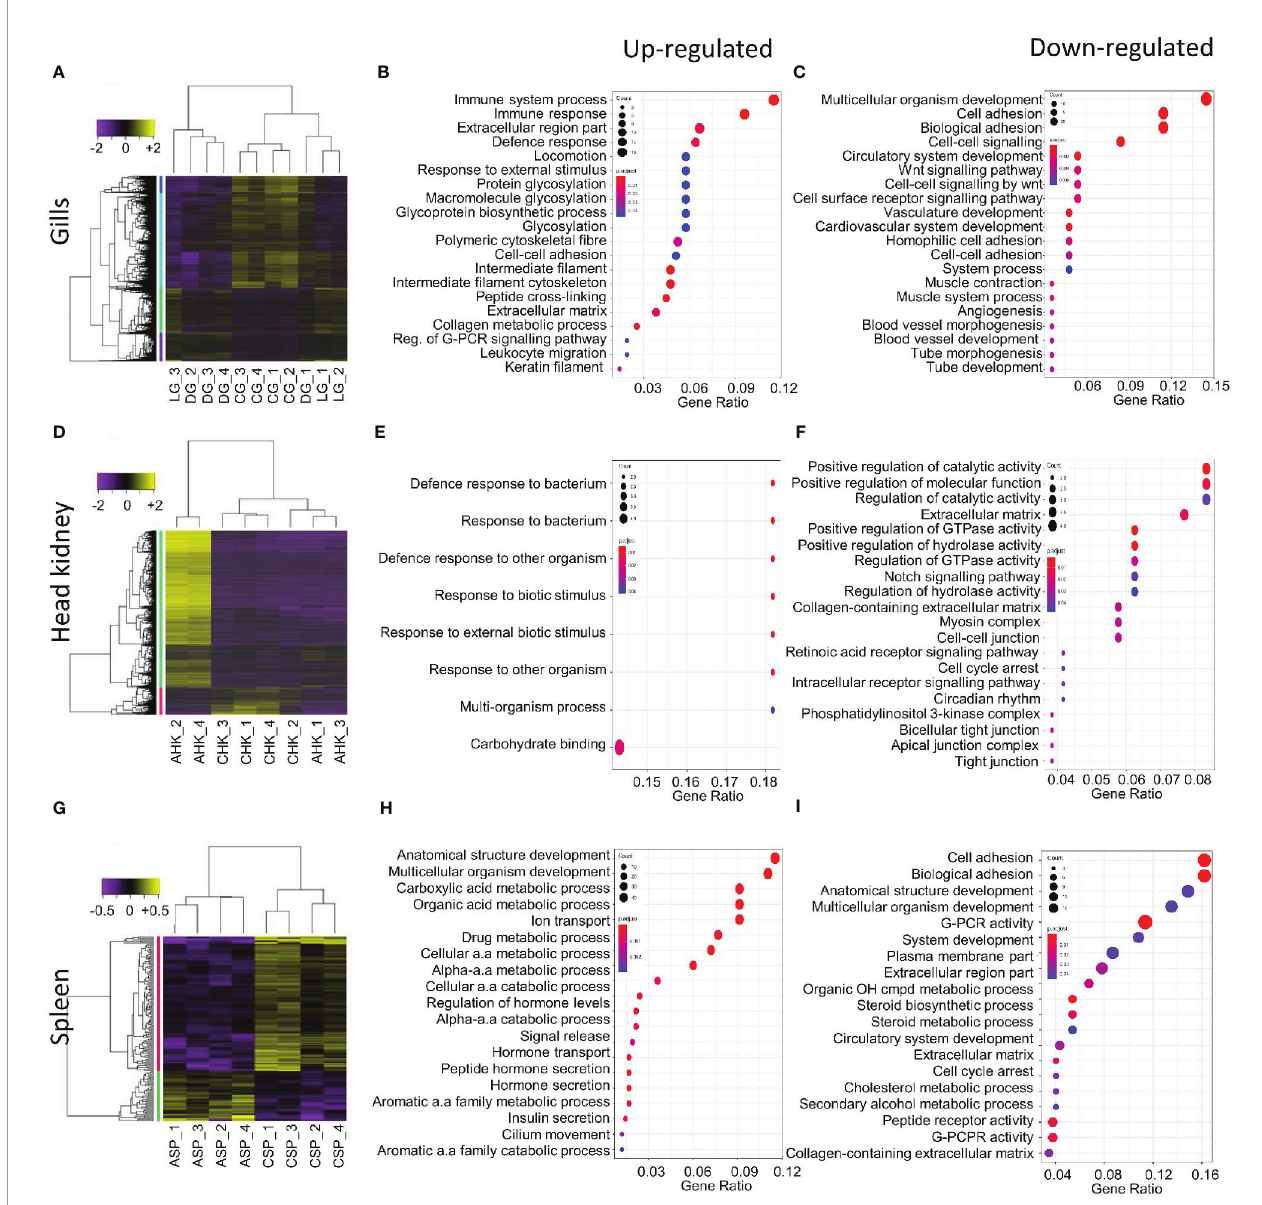
FIGURE 2 | Summary of the host transcriptomic response during amoebic gill disease (AGD) progression. Differential gene expression and signi fi cantly enriched gene ontology (GO) terms are shown for the local (A – C) and systemic (D – I) response to AGD in Atlantic salmon. Heat maps show hierarchical clustering of differentially expressed genes (rows) with differential expression among replicates from a naïve (C) and AGD-affected (A) Atlantic salmon. Expression values are log 2 - transformed and median-centered by gene. (A) The local response is characterized by differential gene expression (fold change > 2; corrected P-value < 0.01) and includes a gill (G) biopsy distal (D) to the lesion (L) of an AGD-affected fi sh. The systemic response among head kidney (HK) (D) and spleen (SP) (G) replicates is characterized by differential gene expression (fold change > 2; corrected P-value < 0.05). Enriched gene ontology (GO) terms (hypergeometric test, Bonferroni-adjusted P < 0.05) among the differentially expressed genes for the gills (B, C) , head kidney (E, F) and spleen (G, H) along with the gene ratio for the genes that map to each term. The majority of the enriched terms are related to host defense and immune